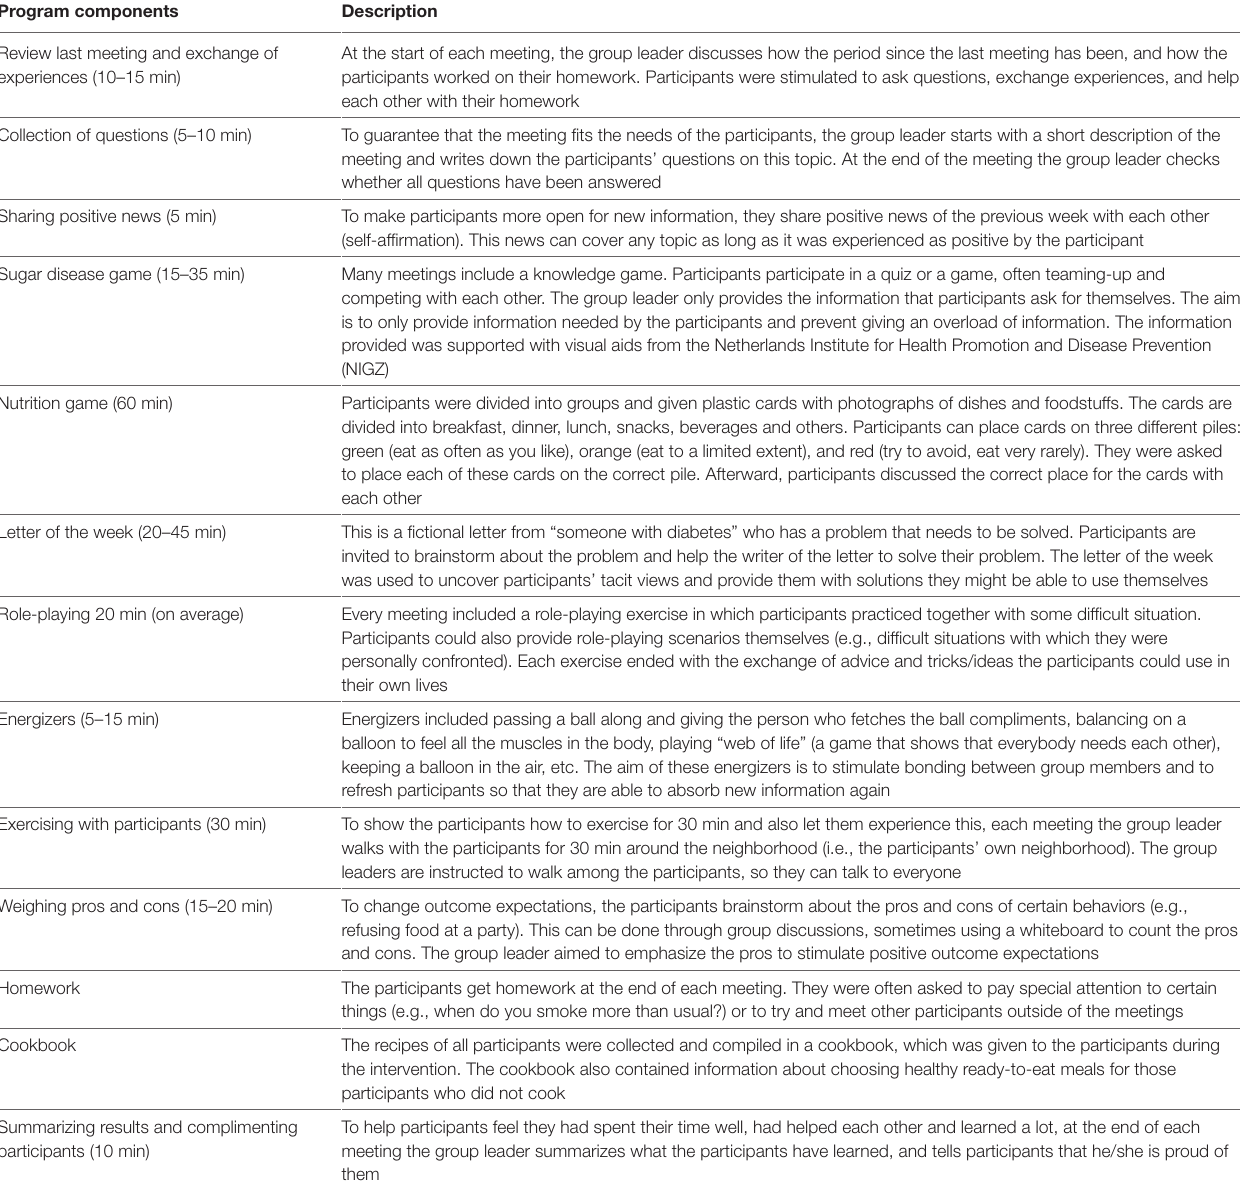
TaBle 3 | Program components: phase 1. Program components